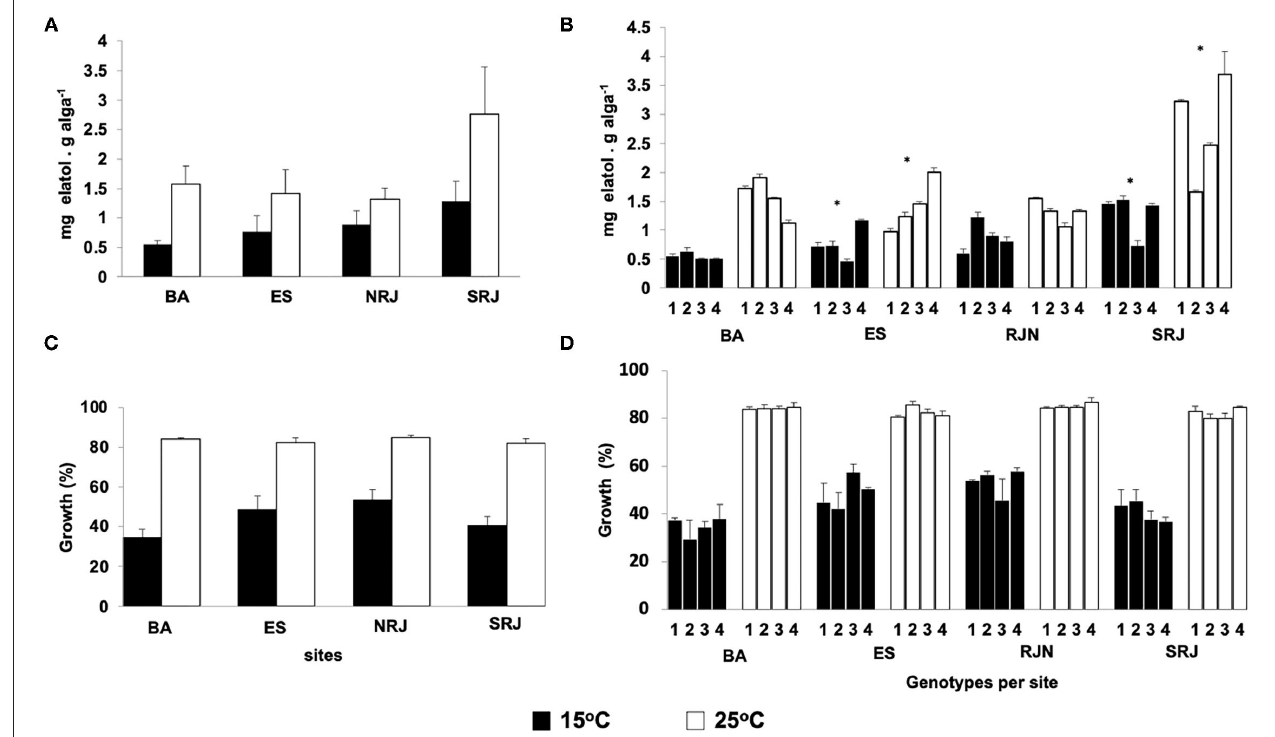
FIGURE 2 | Effect of temperature on the chemical defense and growth of L. dendroidea specimens under laboratory-controlled conditions. At 25 ◦ C, elatol levels (A) and growth (C) were higher than at 15 ◦ C. Elatol levels differed between genotypes ( n = 3) despite similar growth conditions for ES and SRJ populations (B) . The mean growth ( ± SD) of each genotype ( n = 3) was similar at 15 and 25 ◦ C (D) . Numbers 1, 2, 3, and 4 correspond to the distinct genotypes of the unfertile sporophyte lifecycle phase. *Genotypes are significantly different. Sites and statistical notation as in Figure 1 .